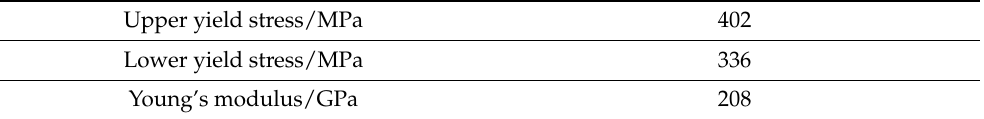
Table 3. Fatigue test